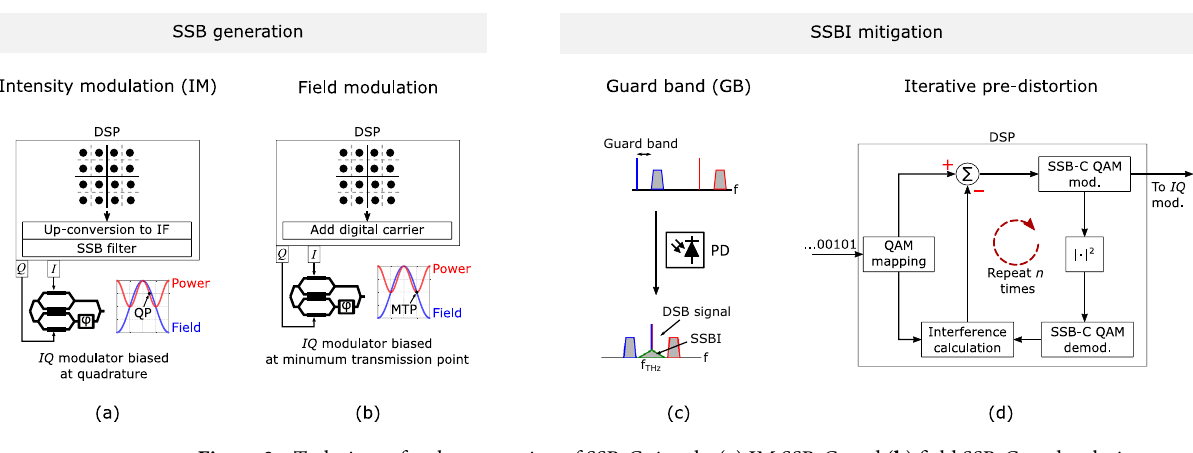
Figure 3. Techniques for the generation of SSB-C signals: ( a ) IM SSB-C, and ( b ) field SSB-C; and techniques for the mitigation of the signal-signal beat interference (SSBI): ( c ) setting a guard band (GB) between carrier and sideband, and ( d ) iterative